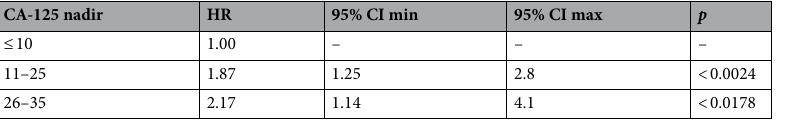
Table 2. Ovarian cancer recurrence risk was related to the CA-125 nadir level after first-line treatment in patients with complete remission. HR hazard ratio, CI confidence